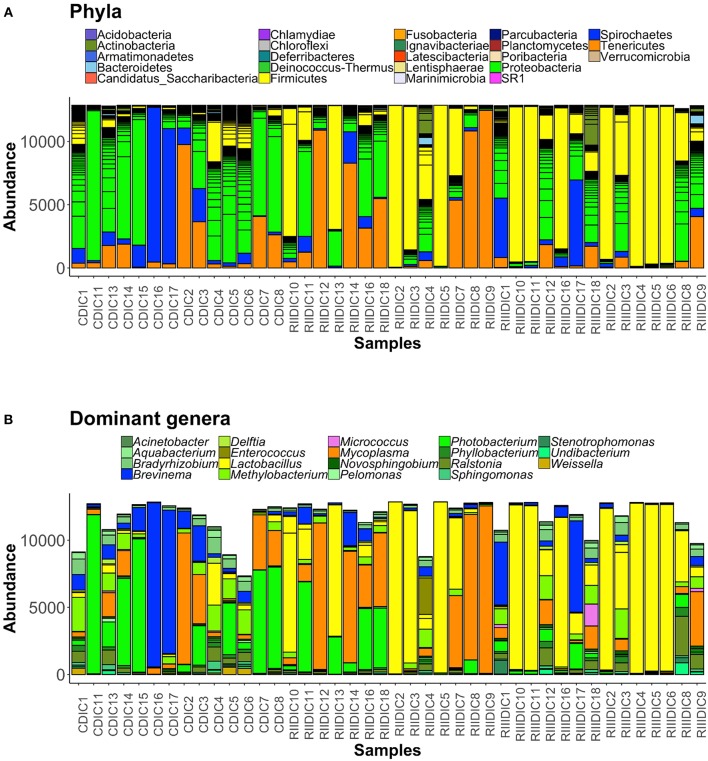
Barplots showing the abundance of all bacterial phyla (A), and dominant genera (B), in the intestinal content. The height of each bar segment represents the abundance of individual operational taxonomic units (OTUs) stacked in order from greatest to smallest, and separated by a thin black border line. Color codes for the dominant genera: Proteobacteria—shades of green, Spirochaetes—dark blue, Firmicutes—shades of yellow, Actinobacteria—orchid, and Tenericutes—dark orange.